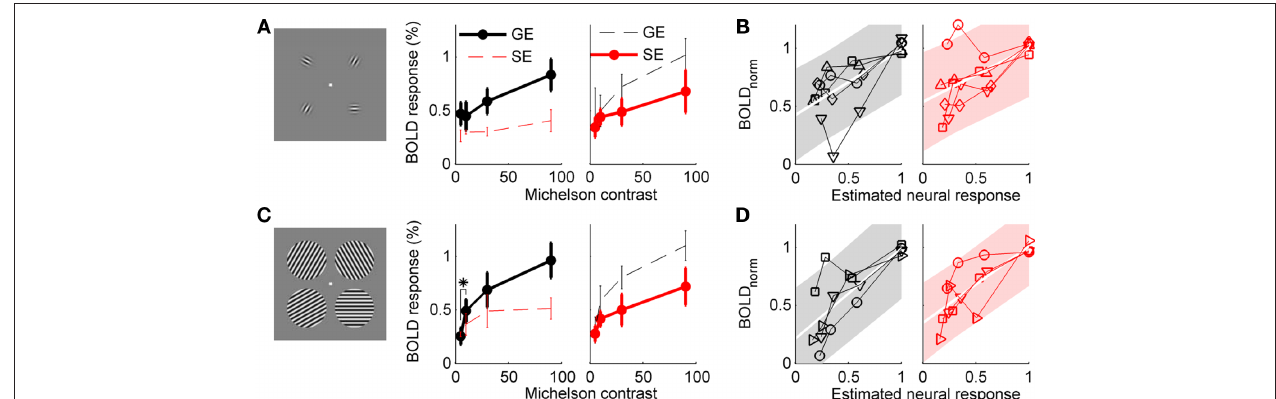
Dashed lines indicate crossed analyses (GE BOLD CRF in SE BOLD ROI, and vice versa ). Error bars indicate SEM. Asterisk indicates p < 0.05, paired t -test, n = 5. (B) Normalized BOLD data are plotted against psychophysical estimates of contrast response in individual subjects, GE data in black on left, SE data in red on right. Shaded area indicates 95% confidence intervals for a linear fit (white line) to the data. (C,D) Control experiment, using grating patches as stimuli ( n